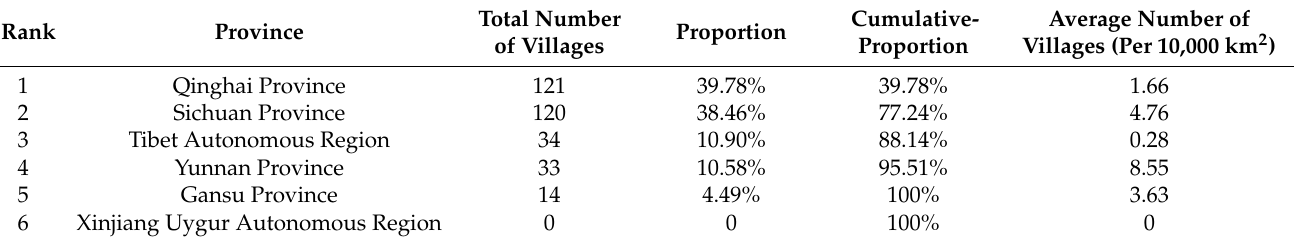
Table 3. Distribution of traditional villages in provinces on the Tibetan